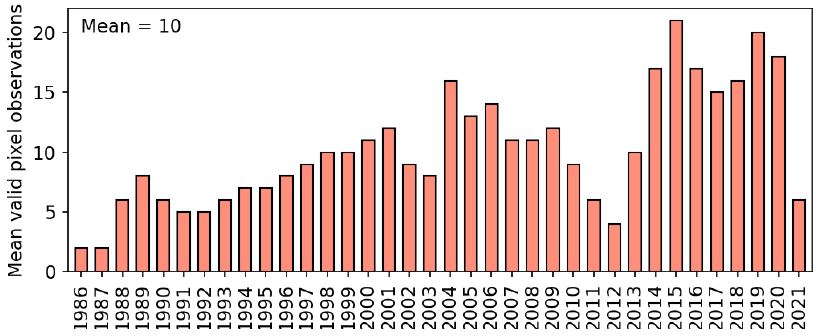
Figure 12. Mean number of valid (cloud-free) observations per pixel from 1986 –